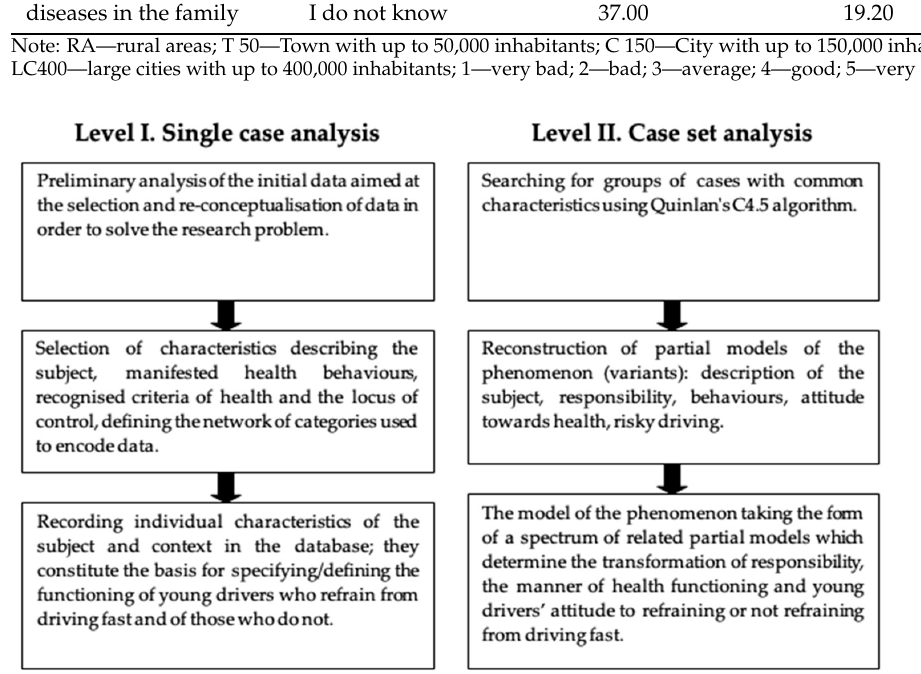
Figure 1. Data analysis scheme: The Process Transformation Reconstruction (PTR) Strategy (a modified version).